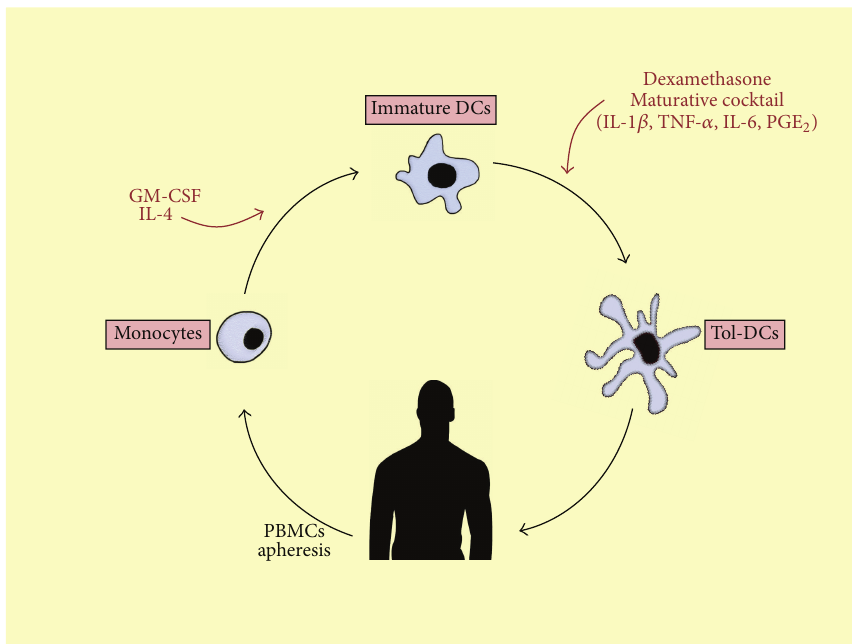
Figure 2: General scheme: dendritic cell therapy for Crohn’s disease patients. Isolated monocytes are cultured and differentiated into DCs by adding IL-4 and GM-CSF to the media. At day 3, addition of dexamethasone induces the tolerogenic profile, and at day 6, addition of the maturation cytokine cocktail potentiates the tolerogenic